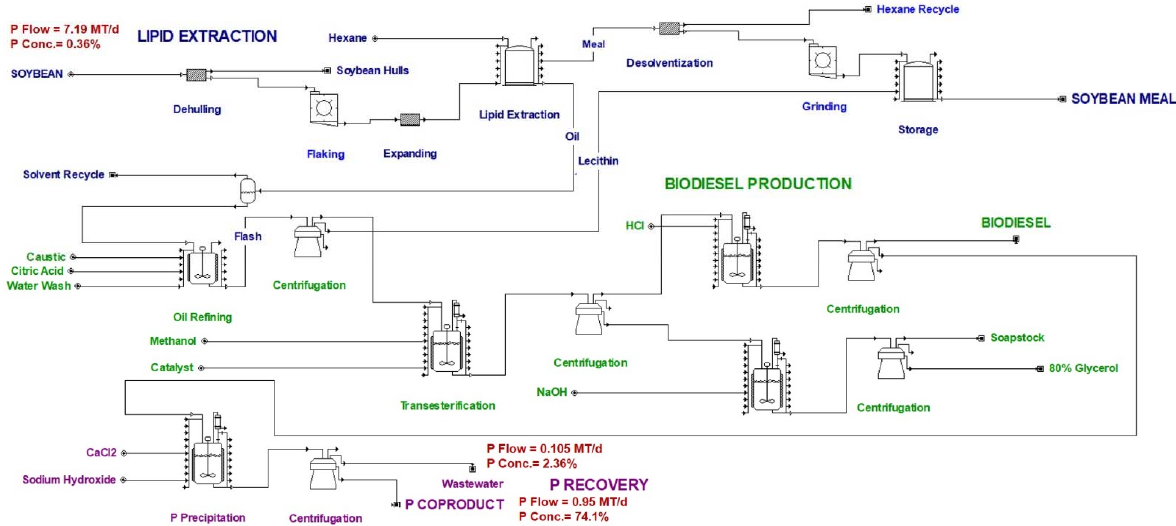
Figure 3. Schematic representation and P flows in the soybean biodiesel process with P recovery from wastewater (PRWW).